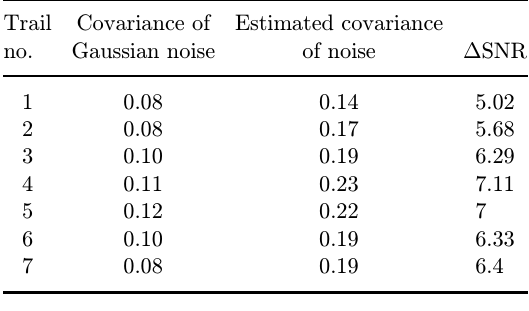
Table 2. Results of applying ARMA based method to simulated data.